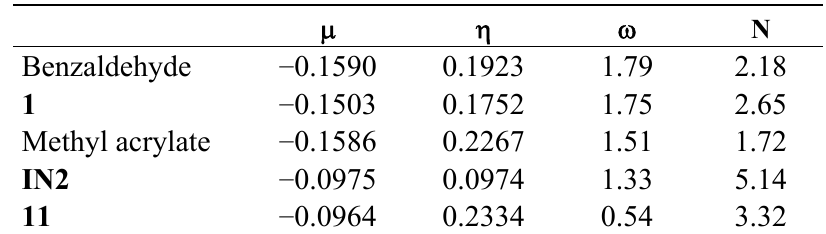
Table 2. Electronic chemical potential (  , in a.u.), chemical hardness (  , in a.u.), global electrophilicity (  , in eV), and global nucleophilicity (N, in eV) of salicylaldehyde 1 , NHC 11 and Breslow intermediate IN2